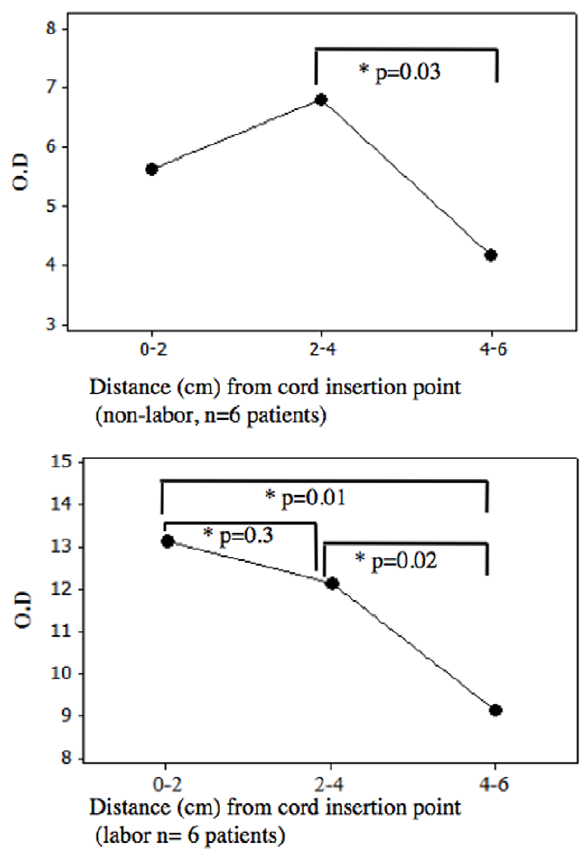
Figure 3. Shows the optical densities for HSP 70 expression in three different placenta zones for all patients. The upper panel shows non-labor (n=6 patients) and the lower panel shows labor (n=6